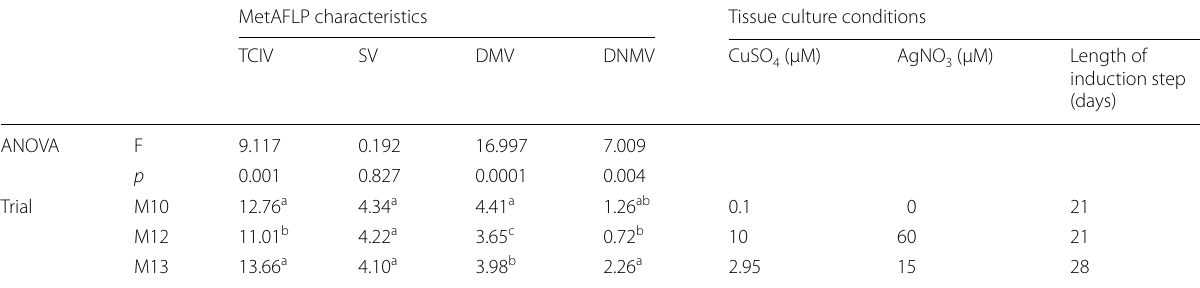
M10 states for control, whereas M12-M13 for the verification trials. TCIV, SV, DMV, and DNMV, reflect tissue culture-induced variation, sequence variation, demethylation, and de novo methylation. The a, b, and c indicate Tukey’s HSD grouping. The presented data does not include outliers that were excluded based on the Grubs test